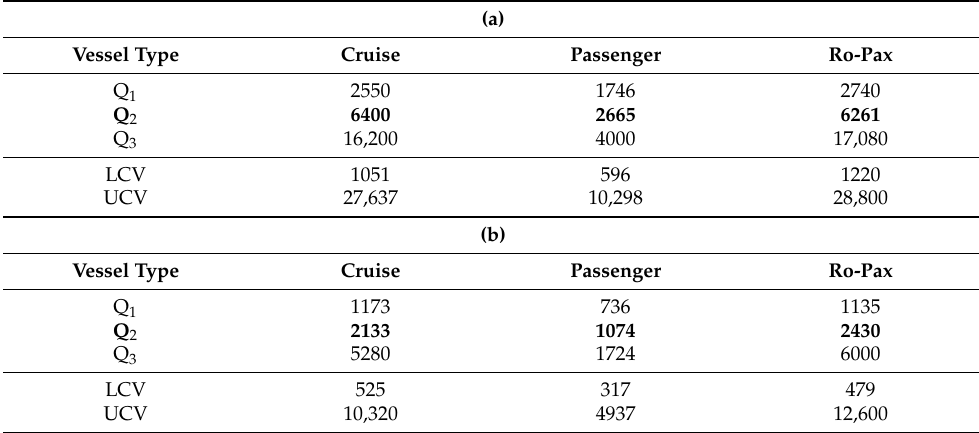
Table 2. Database statistics for ( a ) Total installed power and ( b ) Average engine size. Quartiles Q 1 and Q 3 correspond to the lower and upper boundaries of the boxplot in Figure 1; Q 2 is the median of the distribution and LCV and UCV are the lower and upper extremes of its 95% confidence interval. All reported values are expressed in